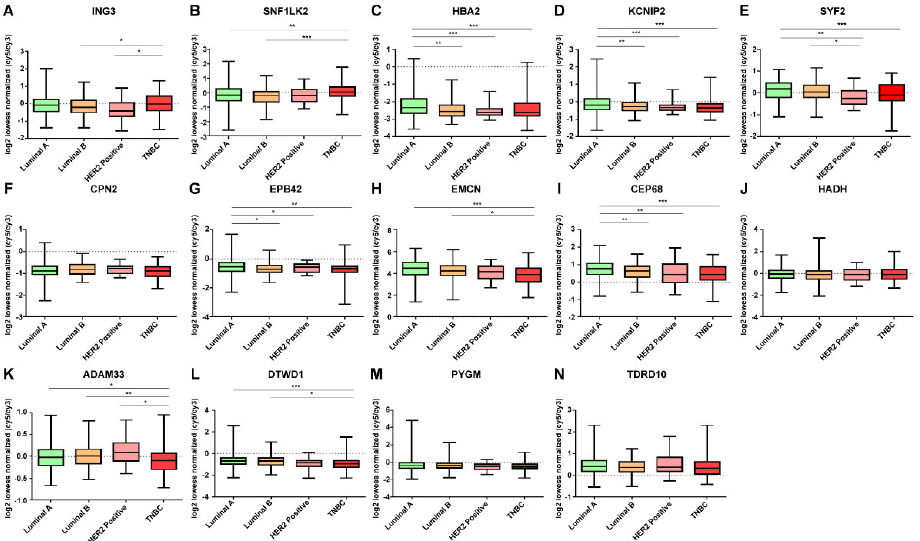
Figure 7. Expression patterns of DE mRNAs downregulated in breast cancer tissue according to molecular subtypes. ( A ) ING3, ( B ) SNF1LK2, ( C ) HBA2, ( D ) KCNIP2, ( E ) SYF2, ( F ) CPN2, ( G ) EPB42, ( H ) EMCN, ( I ) CEP68, ( J ) HADH, ( K ) ADAM33, ( L ) DTWD1, ( M ) PYGM, and ( N ) TDRD10. Data are reported as mean ± SD. * p < 0.05, ** p < 0.01, *** p < 0.001.